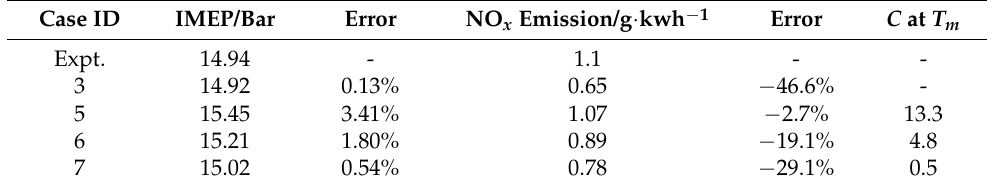
Table 8. IMEP and NO x emission prediction results of cases 3, 5, 6 and 7 and the experimental